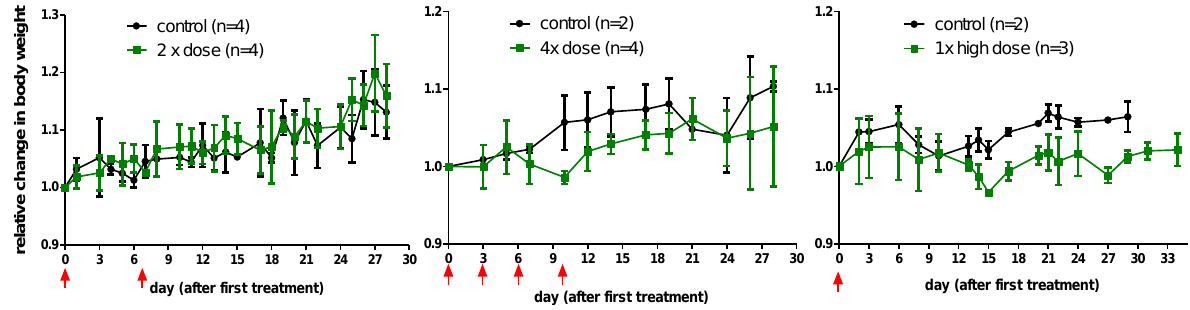
Figure S3. Relative change in body weight of the nude mice after a single high ( right ) dose or a two-time ( left ) or four-time ( middle ) sequential dose of [ 177 Lu] NT127 in comparison with sham-treated animals (control). Data are expressed as mean ± standard